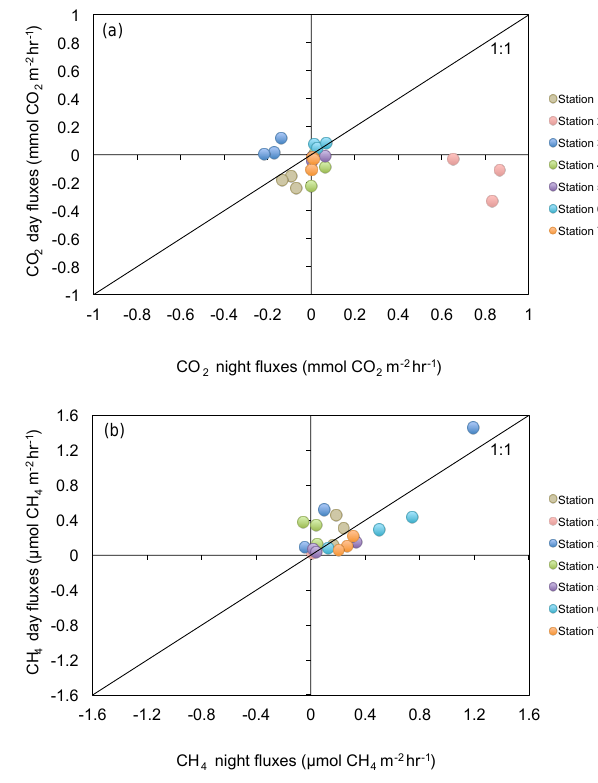
Figure 3. Relationship between day and night fluxes for CO 2 (a) and CH 4 (b) at all mangrove